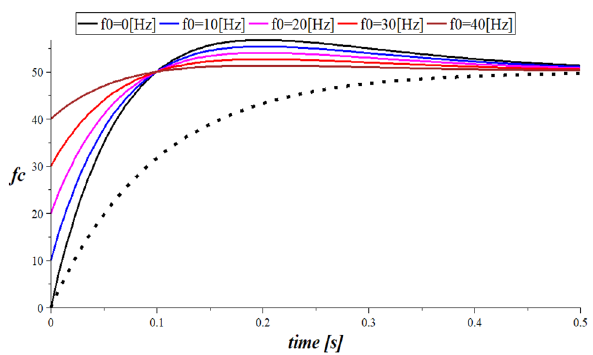
Fig. 12 Static overshoot of frequency of currents 𝛥 f s , for